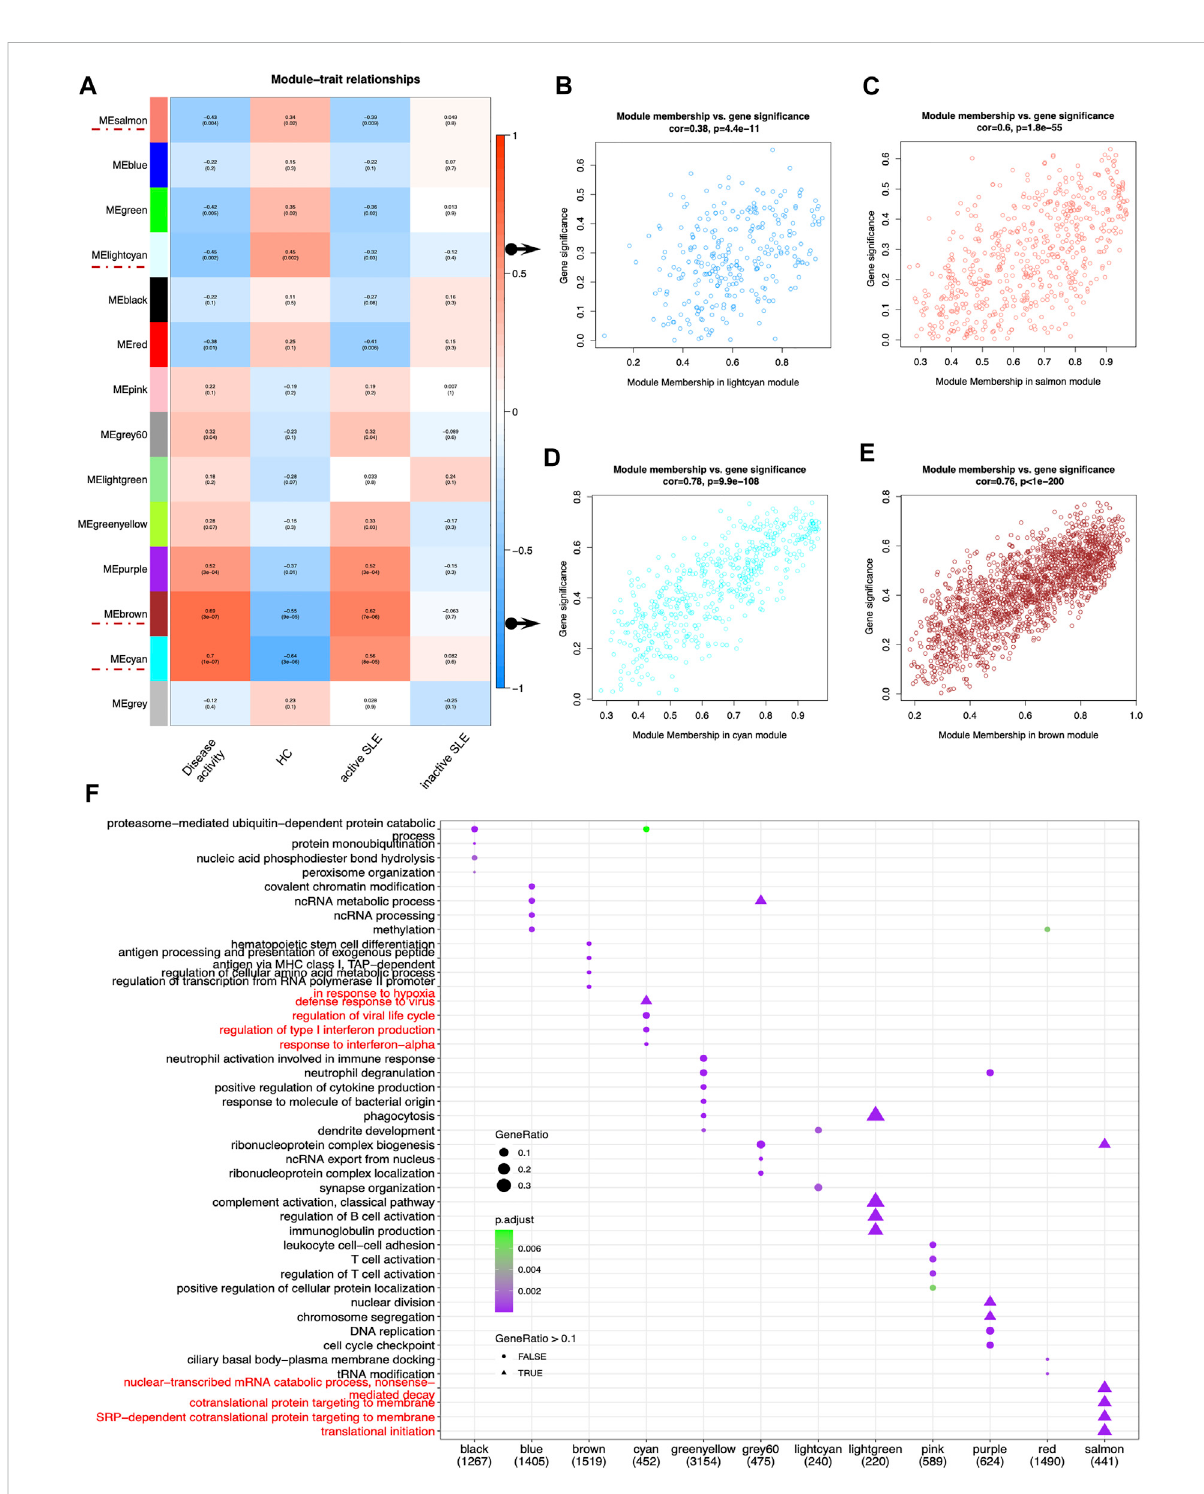
FIGURE 3 Main fi ndings in the module-trait correlations through WGCNA. (A) Module-trait associations. Each row corresponded to a module eigengene (ME), while each column corresponded to a trait. Each cell contained the corresponding correlation and p value. The cells were color-coded by correlation according to the color legend. (B – E) The scatterplots of Gene Signi fi cance (GS) for disease activity vs . Module Membership (MM) in the lightcyan (B) , salmon (C) , cyan (D) and brown module (E) , which represented signi fi cant correlations between GS and MM in these modules. (F) The dot plot of GO enrichment analysis of the genes in different